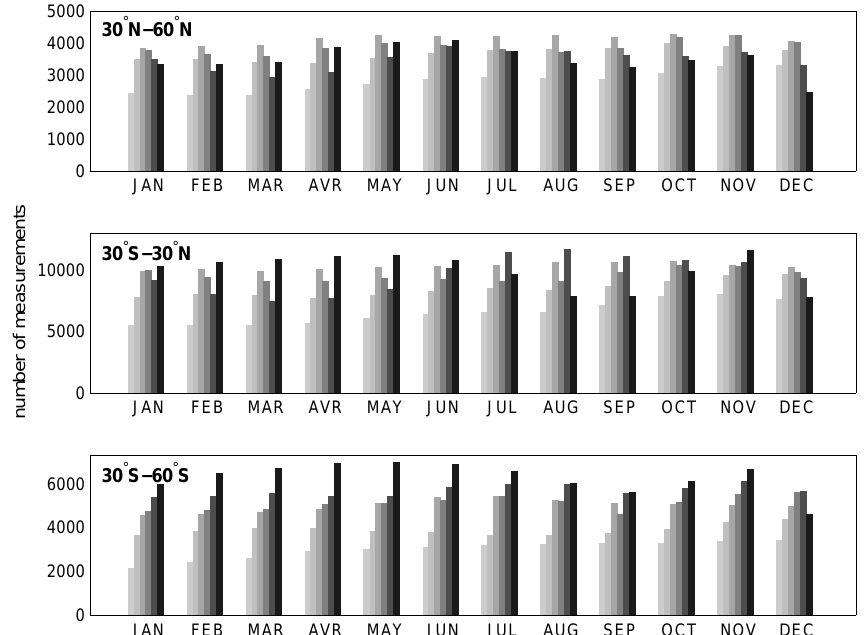
Fig. 1. Number of monthly measurements averaged for different ocean basins, i.e. northern basin 30–60 ◦ N (upper), southern basin 30–60 ◦ S (middle) and tropical basin 30 ◦ S–30 ◦ N (lower). Change of years from 2005 to 2010 shown from light to dark gray. The mean for each 5 ◦ × 10 ◦ × 3 month box is then